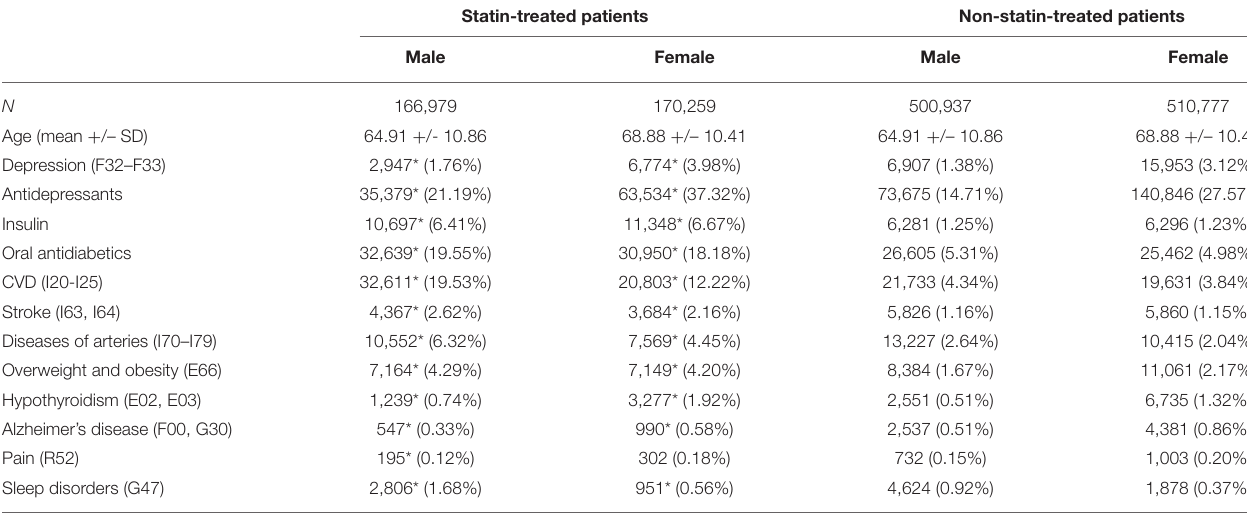
TABLE 1 | Baseline characteristics of the study population, showing group size, age and the absolute and relative frequencies of depression, use of other medications (insulin, oral antidiabetics, antidepressants) and comorbid conditions for males and females in the statin-treated and in the matched control group.